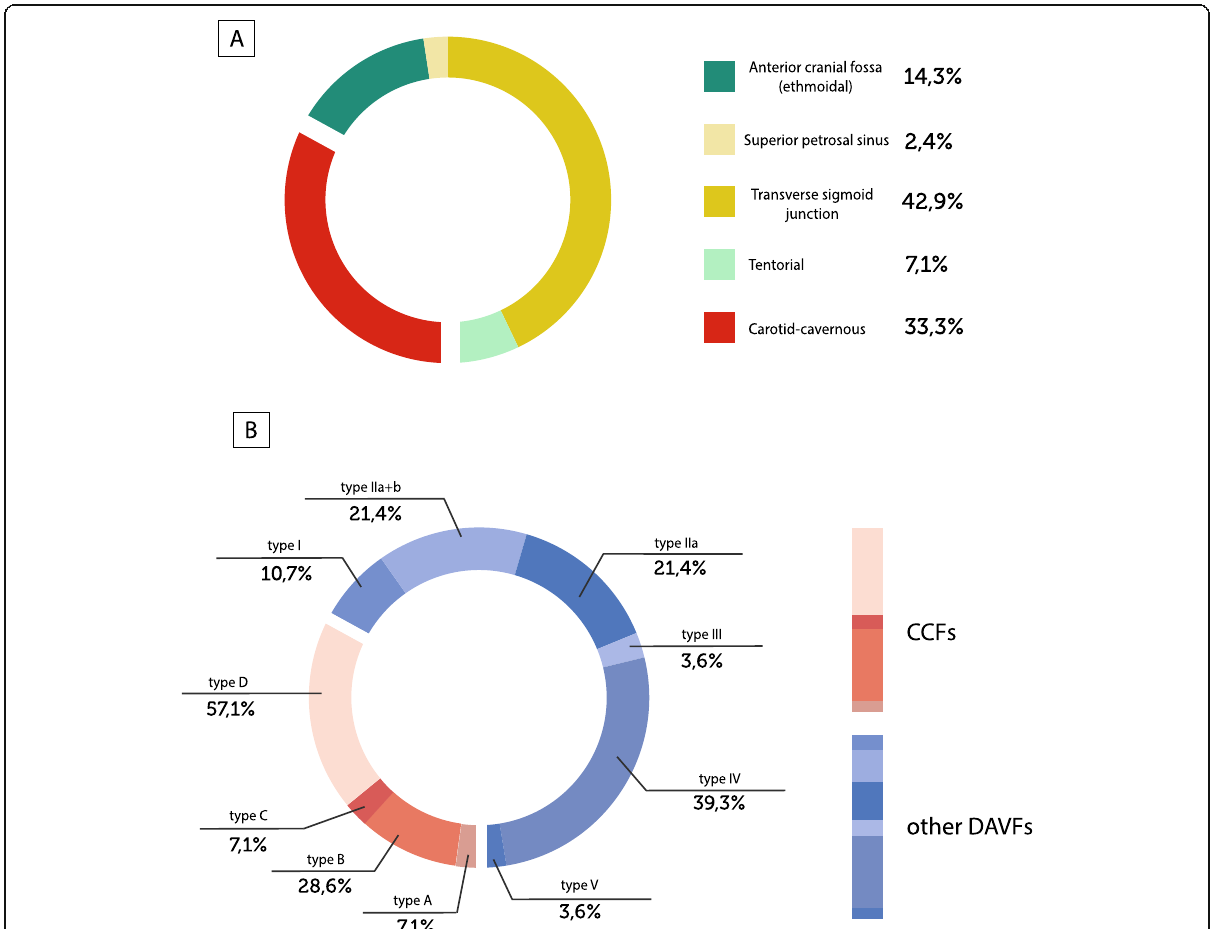
Fig. 2 Subtypes of DAVFs according to angiographic features, Barrow ’ s and Cognard ’ s classifications. A: Location of DAVFs according to angiographic features with related percentages of presentations of our series. None superior sagittal sinus DAVF detected. B: Type of CCFs, according to Barrow ’ s classification (types A, B, C, D) and type of other DAVFs than CCFs, according to Cognard ’ s classification (types I, IIa, IIa + b, III, IV, V) and related percentages of presentations of our series. None type IIb detected. Abbreviations: CCFs = carotid-cavernous fistulas; DAVFs= dural arteriovenous